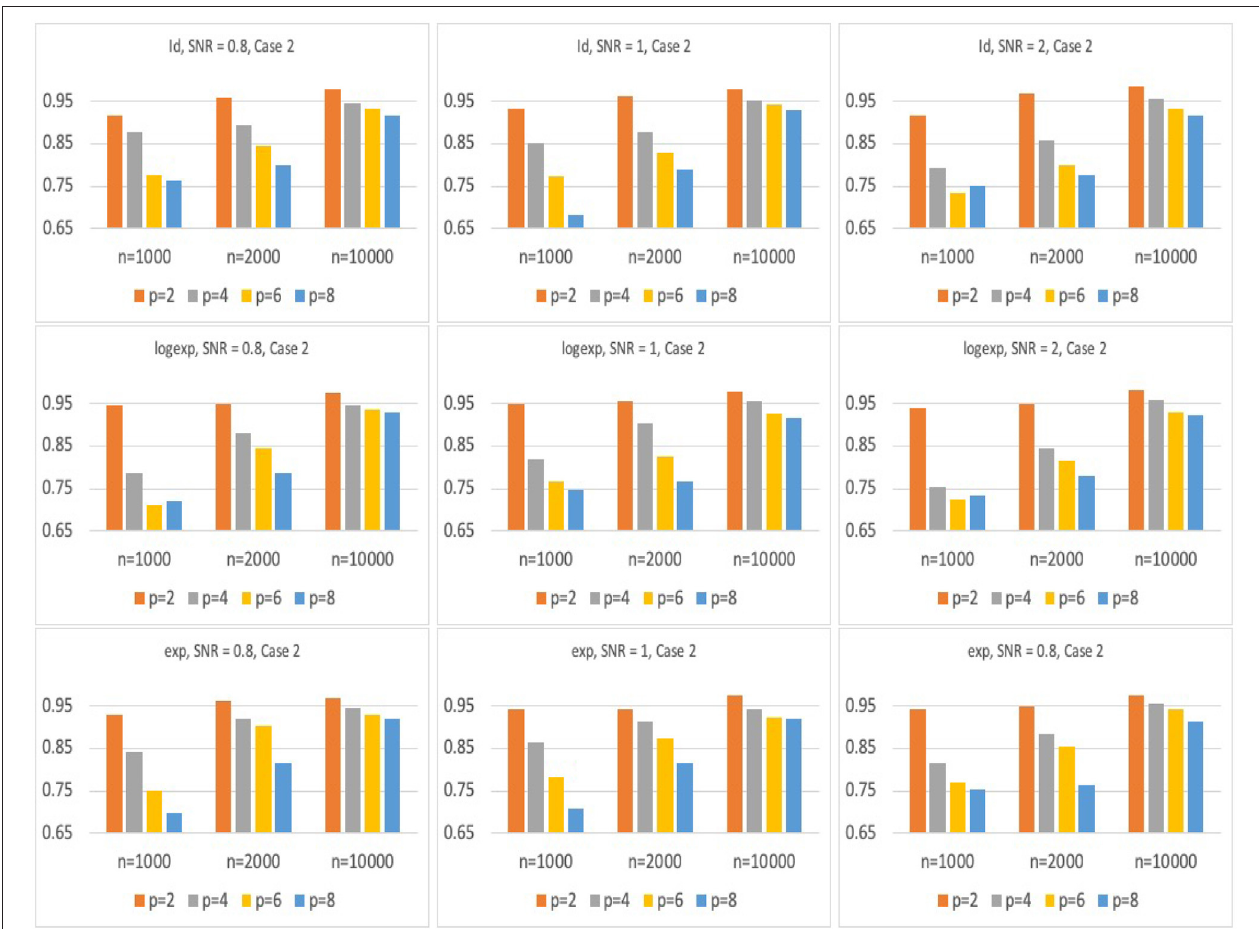
FIGURE 3 | Simulation results of coverage probability for Model 2 with three different link functions, sample size of n = 1,000,2,000,10,000, and p = 2,4,6,8. For each case, prediction coverage probability is calculated over the samples in the testing data set.